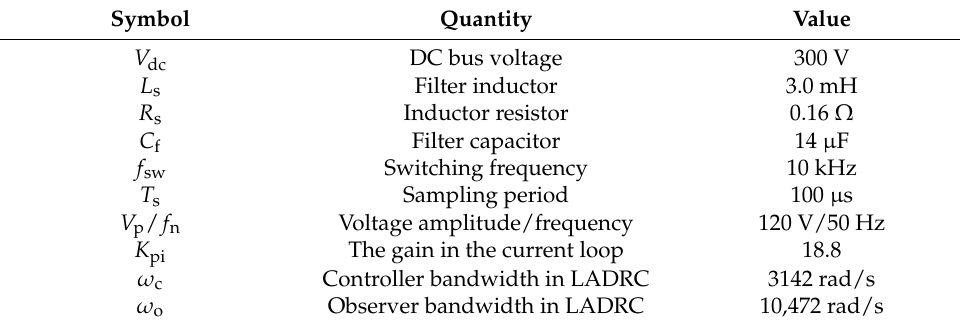
Table 2. Key parameters of inverter and controller in